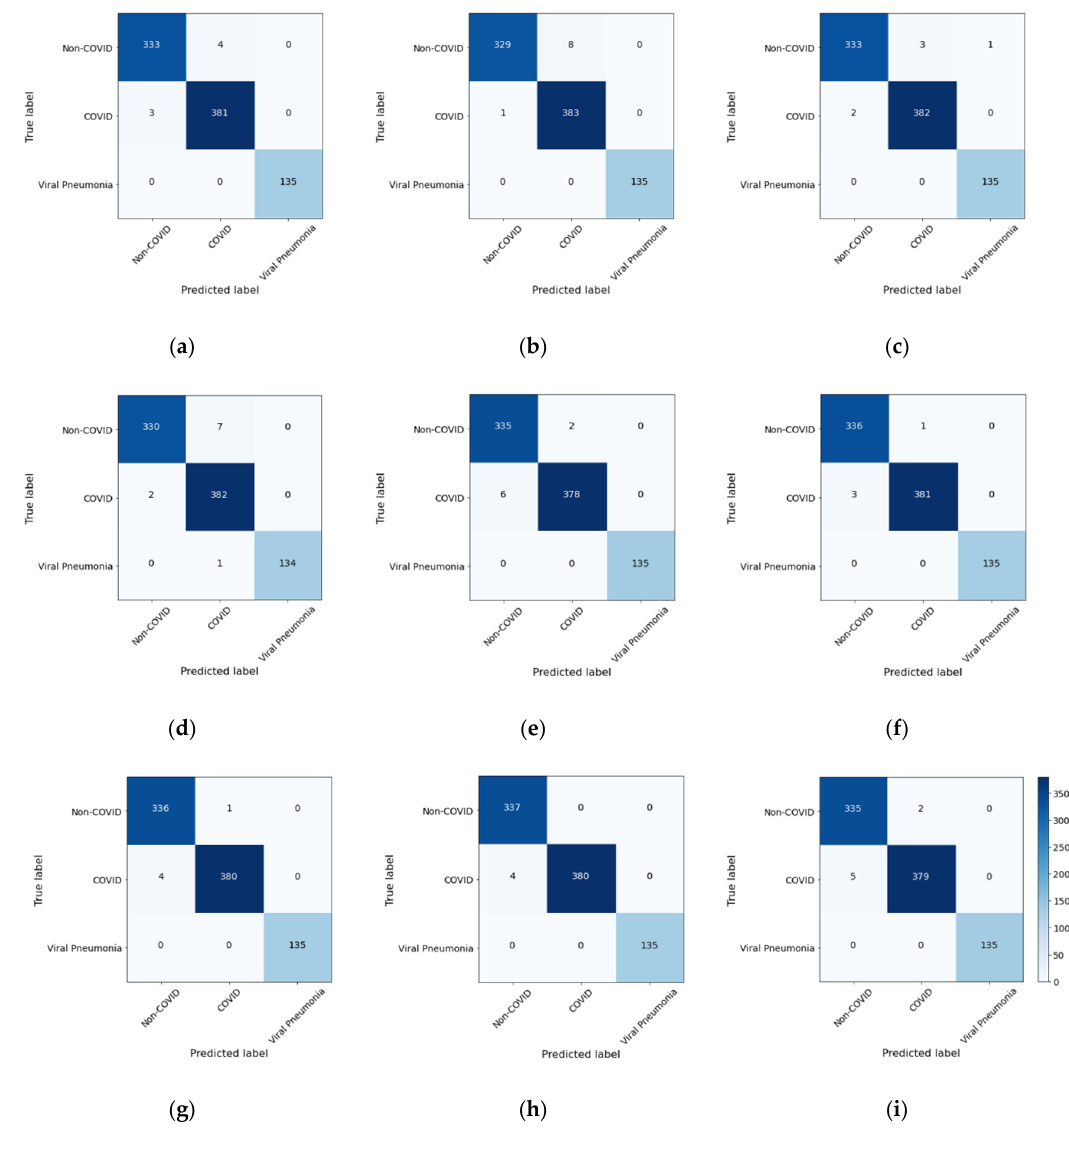
Figure 15. Confusion Matrix for Shallow Meta-Learning Ensemble CNN Models ( a ) Logistic, ( b ) SVC, ( c ) KNN, ( d ) Naïve Bayes, ( e ) Decision Tree, ( f ) Random Forest, ( g ) AdaBoost, ( h ) Gradient Boosting, ( i ) Bagging Ensemble CNN Model.